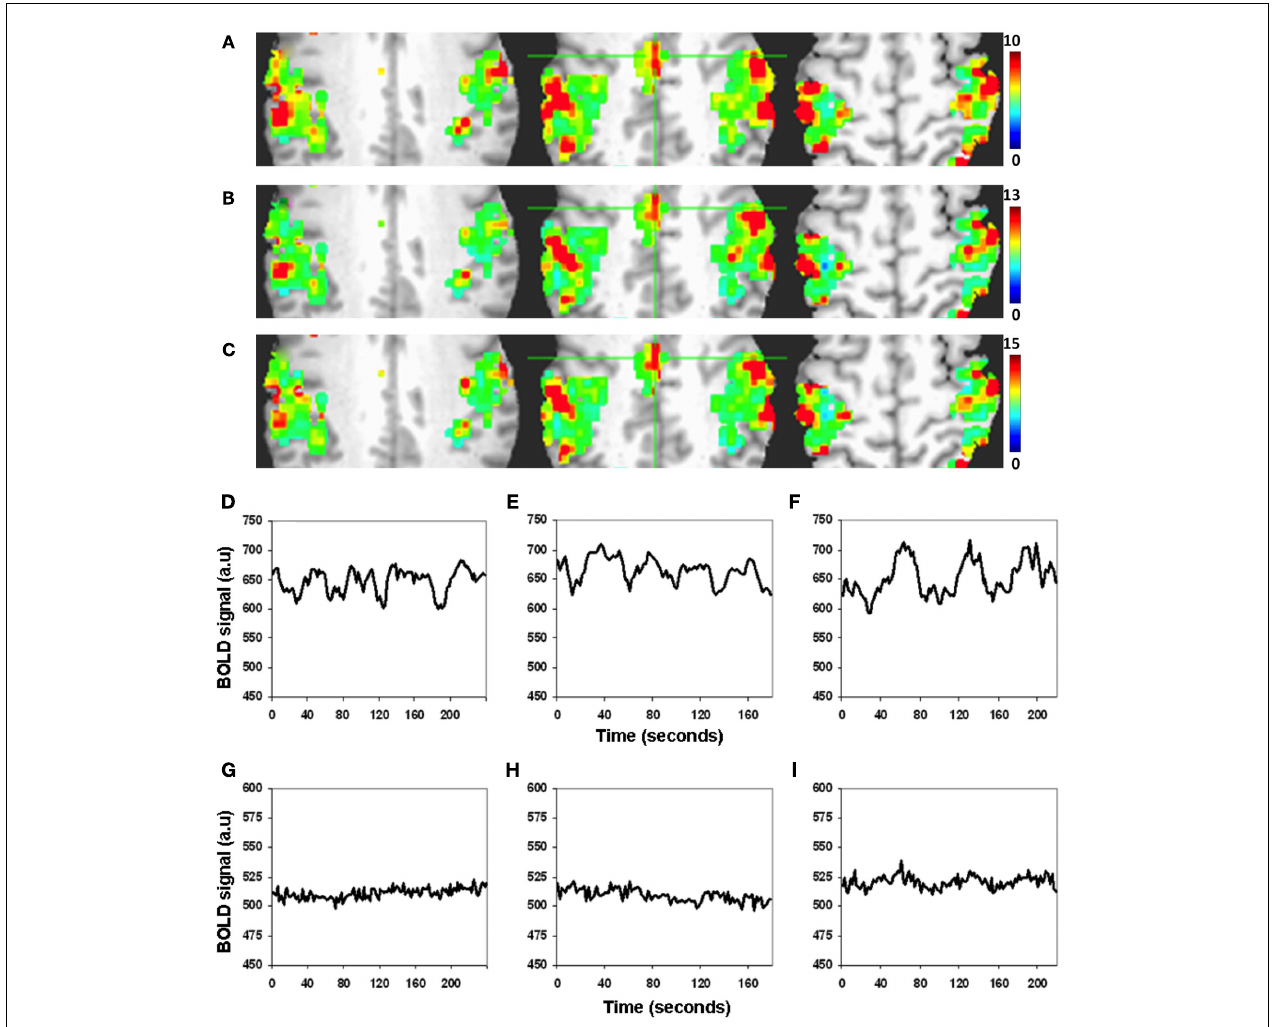
scales have been used to visually normalize the color maps across the different experimental conditions). (D–F) BOLD signal time courses of the R-fMRI,T-fMRI, and hypercapnia respectively from a typical gray matter voxel within the motor-task ROI. (G–I) BOLD signal time courses of the R-fMRI,T-fMRI, and hypercapnia respectively from a typical white matter voxel within the motor-task